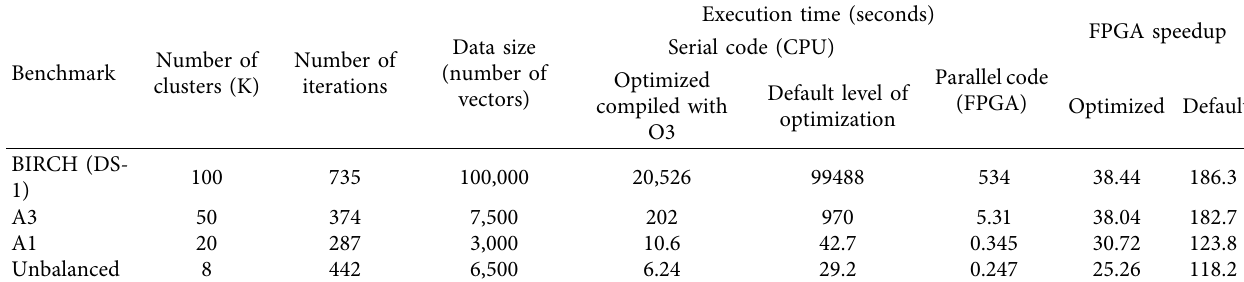
Table 1: Benchmarks execution times for both the CPU and FPGA computation platforms.